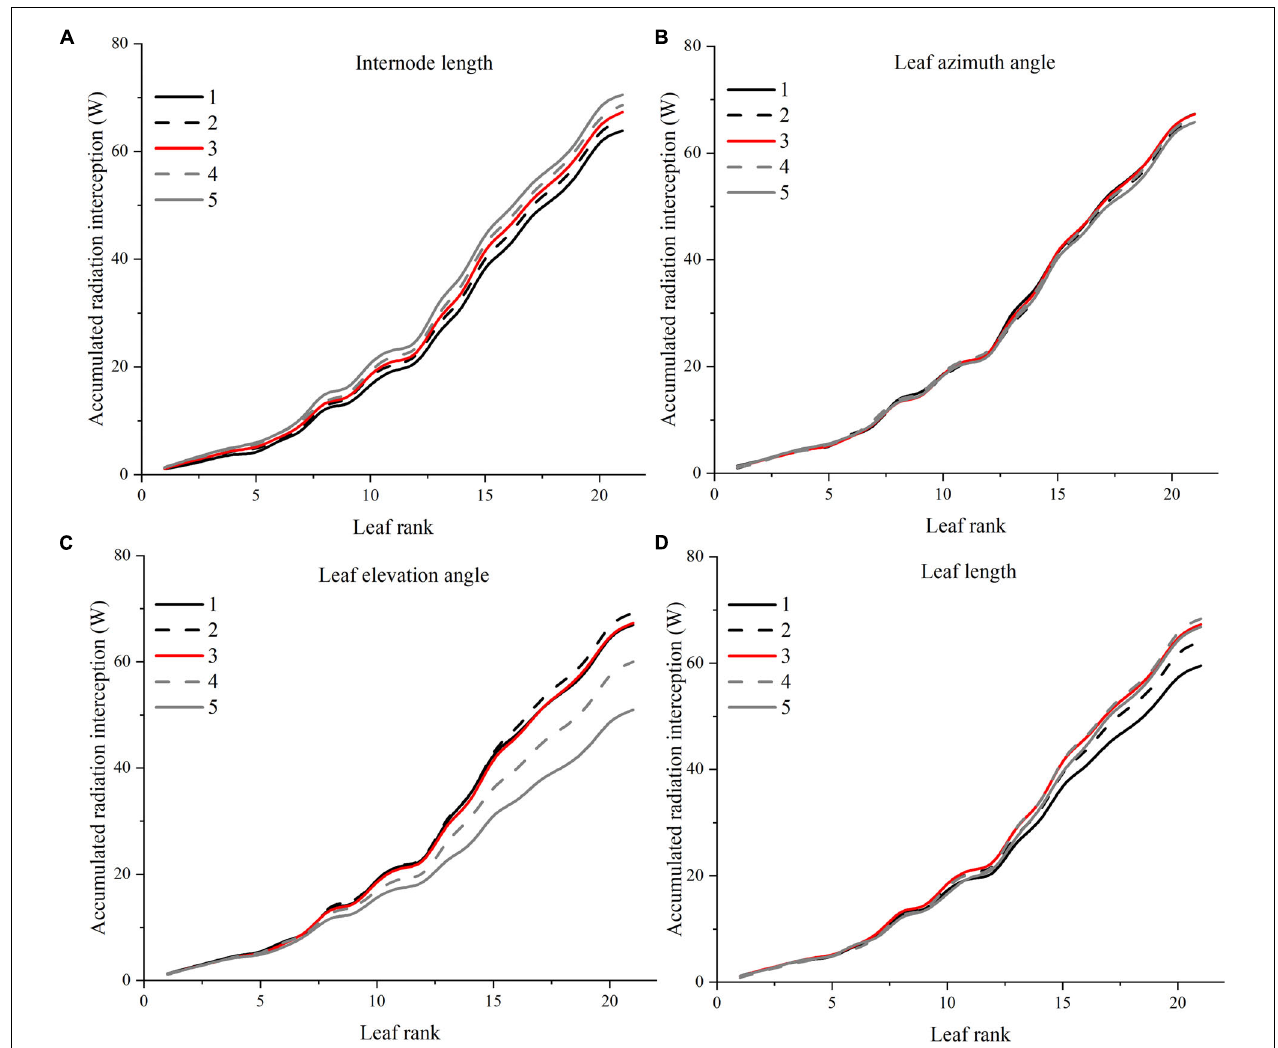
FIGURE 10 | Effects of different leaf architectural shapes on accumulated radiation interception as leaf rank increases. Simulated for the canopy located at the middle of the greenhouse to avoid any border effects. E.g., internode length (A) , leaf azimuth angle (B) , leaf elevation angle (C) , and leaf length (D)